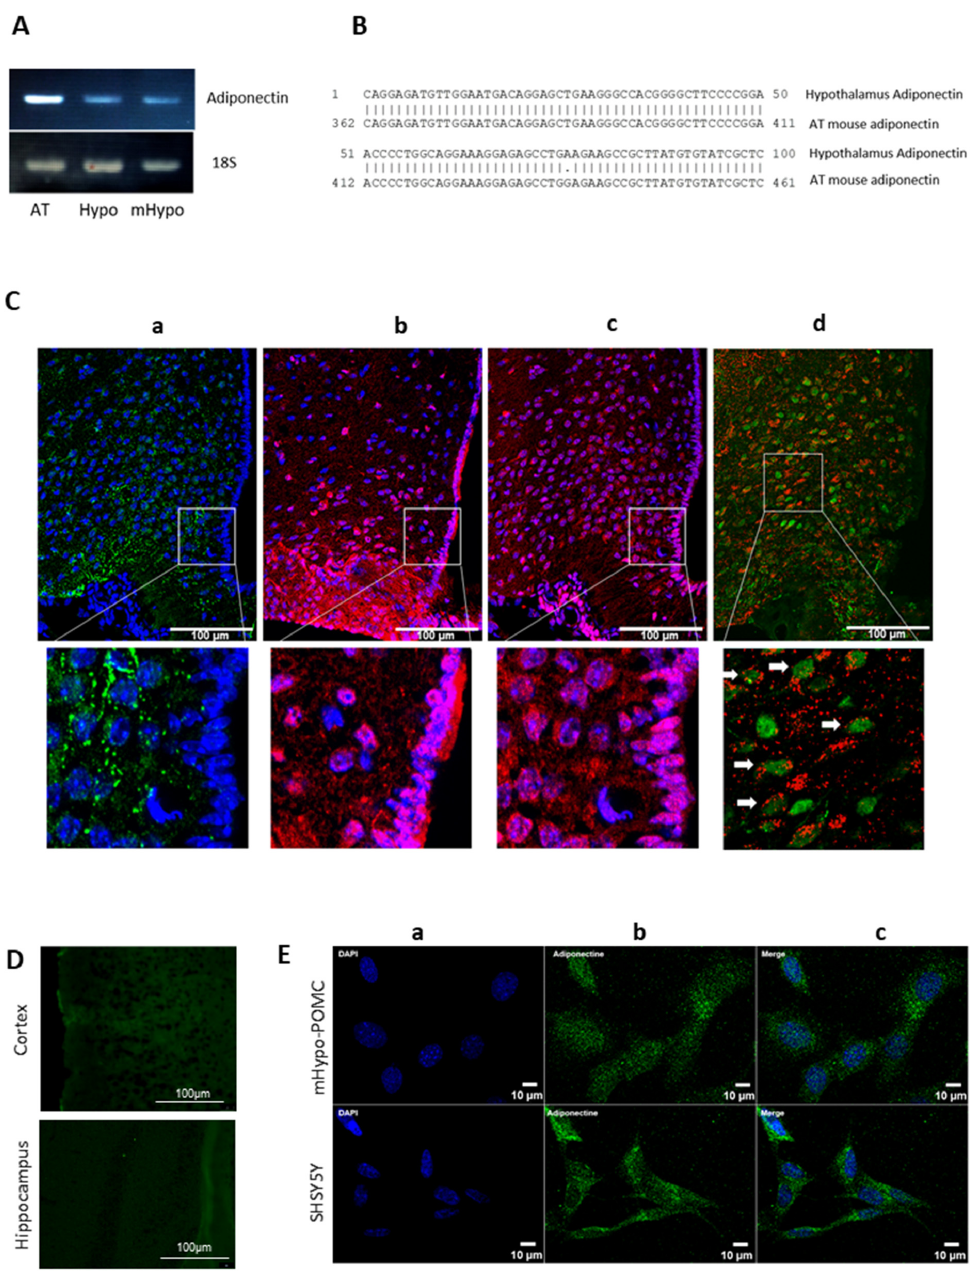
Figure 1. Adiponectin is expressed in hypothalamus and neuronal cells. ( A ) Total RNA from mouse adipose tissue or hypothalamus, and mHypo POMC cells were subjected to RT + PCR targeting mouse adiponectin cDNA and 18S. The amplified fragments were separated in 2% agarose gel stained with ethidium bromide. ( B ) Following purification, amplified fragments were sequenced,